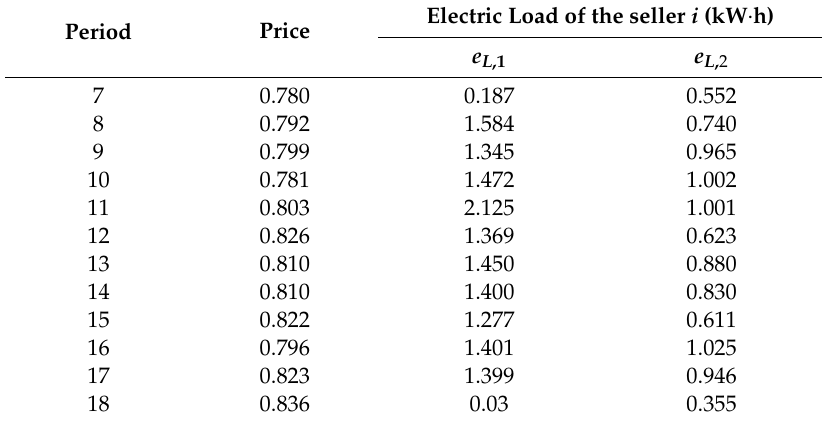
Table 12. Electricity price and transaction volume.